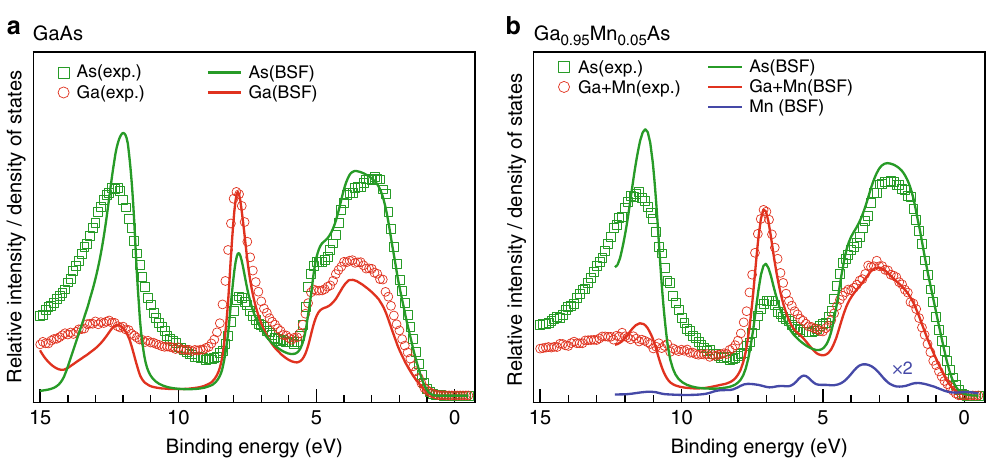
Fig. 5 Elemental projection of angle-integrated experimental data. Projections represent roughly the matrix-element weighted density-of-states of element- resolved components. Experimental data for a GaAs and b (Ga,Mn)As in a (-1-1-1) re fl ection geometry, with photon energy of ∼ 2.7 keV and integrated over the whole-acceptance angle of analyzer are shown as empty circles (red for Ga + Mn) and squares (green for As). The solid curves show element-projected calculated partial densities of states of Ga, As, or Ga + Mn, sites, including coherent potential approximation for the doped sample. The blue curve (whose intensity is multiplied by 2) shows the theoretical projection onto Mn